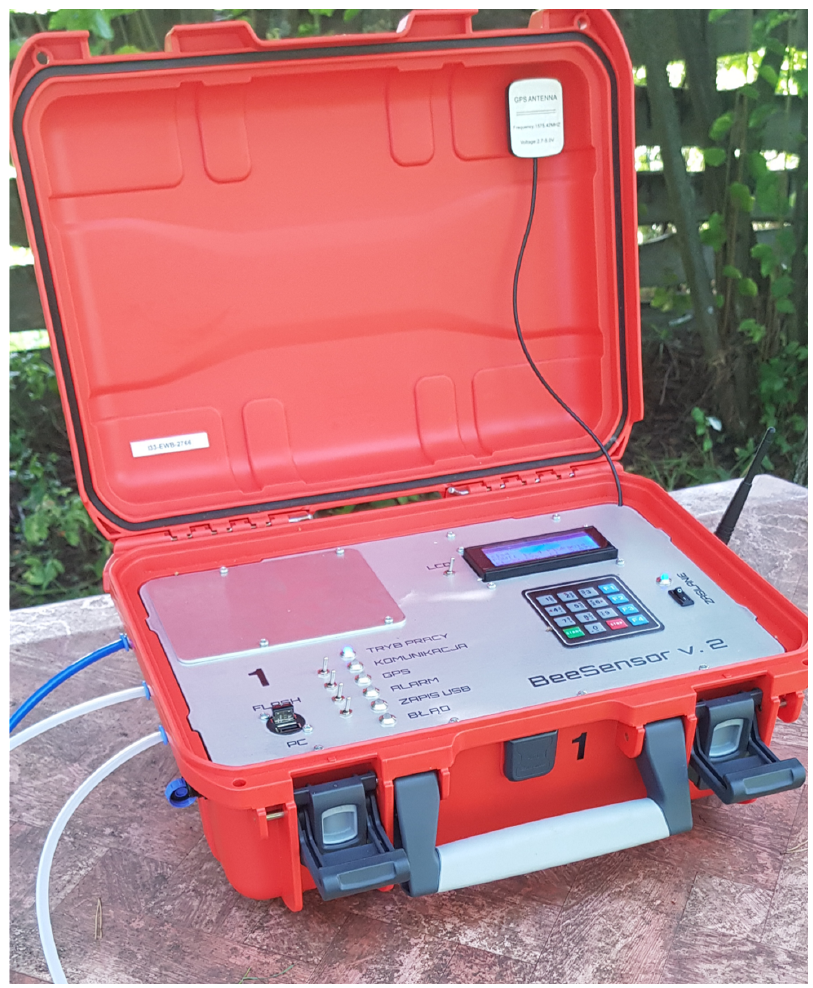
Figure 2. Multi-Sensor Recorder Beesensor